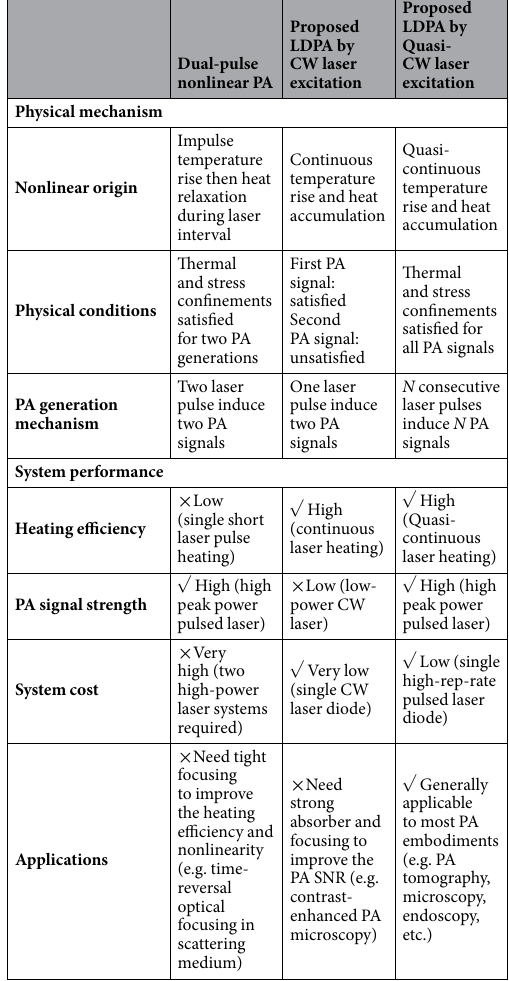
Table 1. The comparison table between the proposed LDPA techniques with the existing dual-pulse nonlinear PA